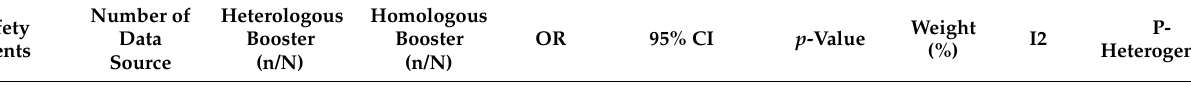
Table 1. Comparison of safety between heterologous booster and homologous